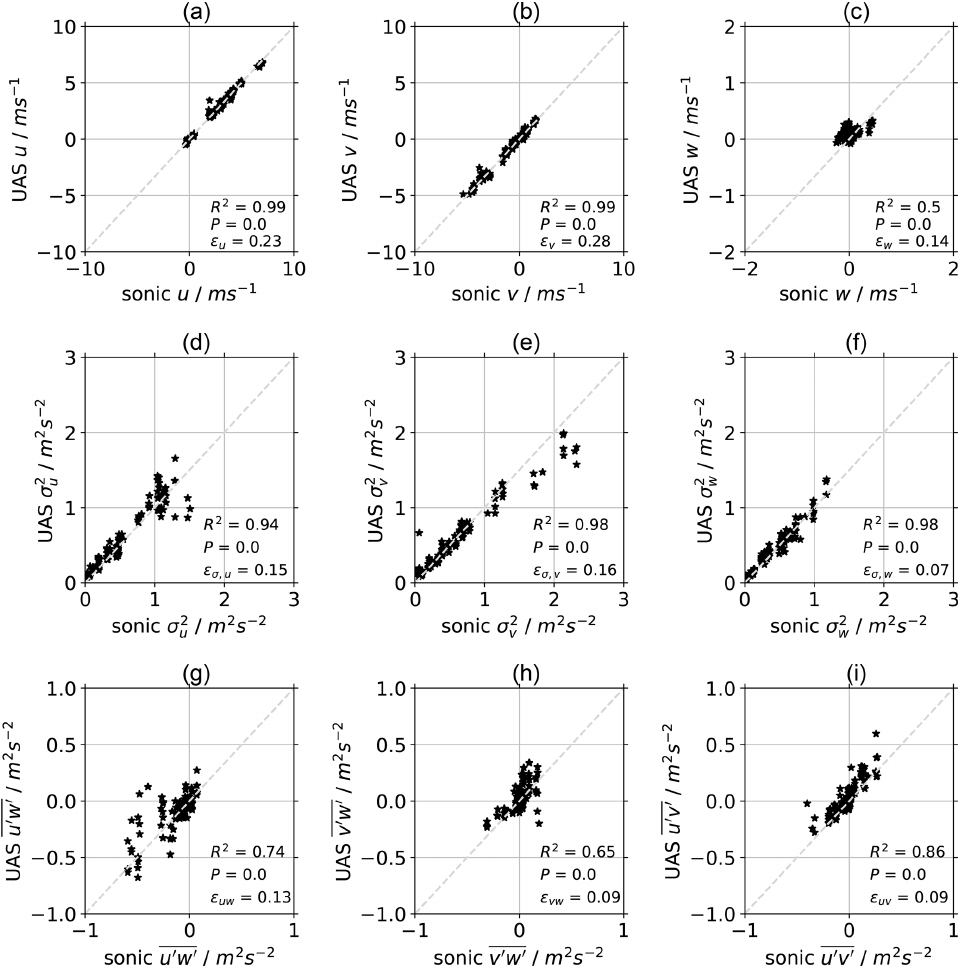
Figure A1. Scatterplots of flight-averaged UAS measurements versus sonic anemometer for u , v , and w (a–c) , as well as the corresponding variances (d–f) and covariances (g–i) in the meteorological frame of